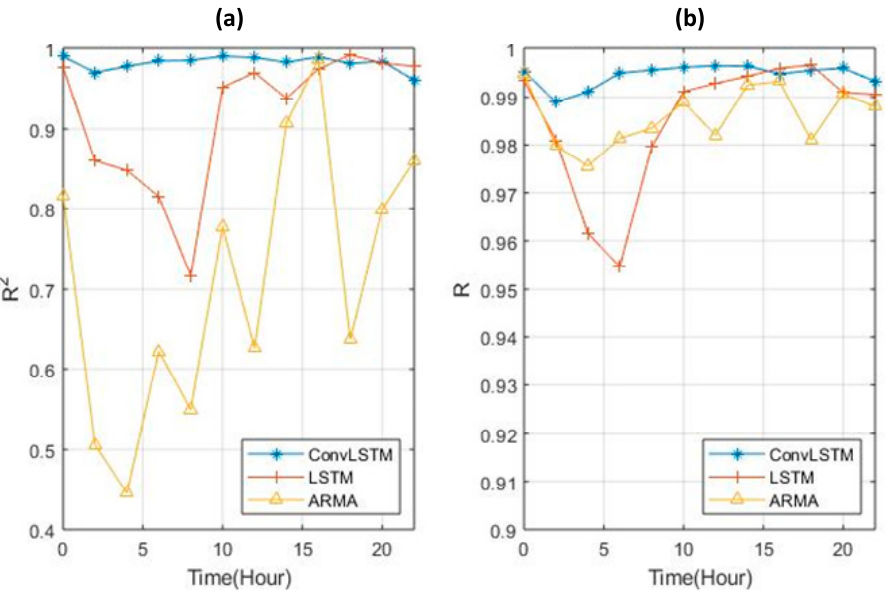
Figure 17. The change in R 2 coefficient ( a, left ) and R correlation coefficient ( b, right ) for the three methods.